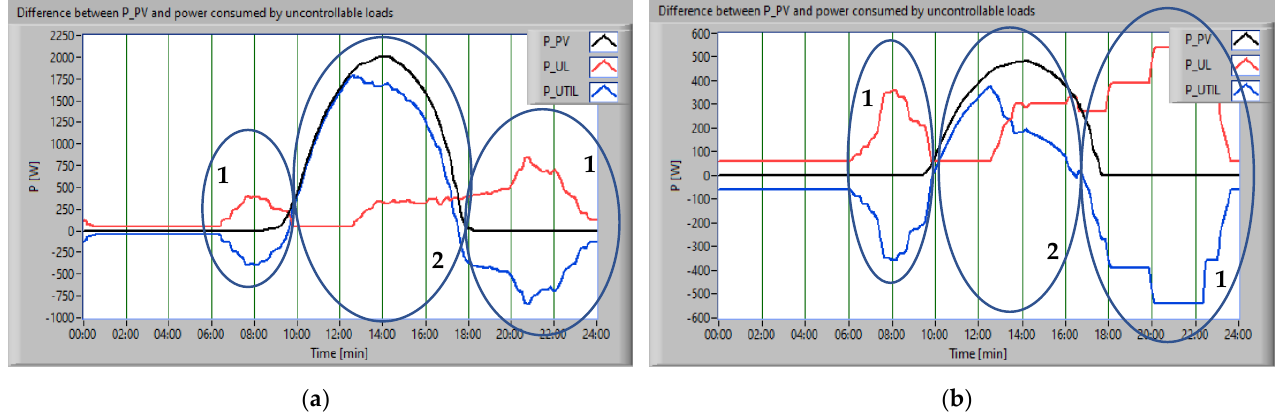
Figure 13. Scheduling for load shifting optimization for ( a ) scenario 1; ( b ) scenario 2.